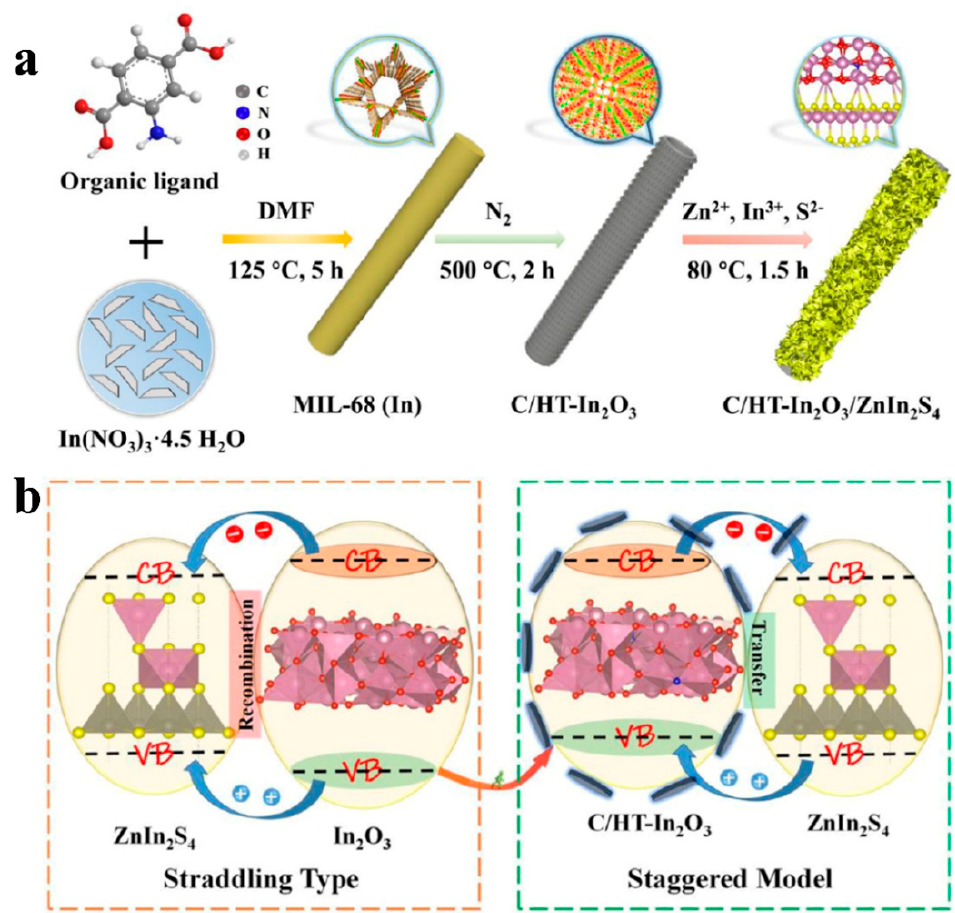
Figure 20. ( a ) The schematic illustration of the synthesis process for the C/HT-In 2 O 3 /ZnInS 4 . ( b ) The comparison of interfacial electron transfer pathways for straddling type (In 2 O 3 /ZnInS 4 ) and staggered model (C/HT-In 2 O 3 /ZnInS 4 ). Reproduced with permission from Ref. [88].